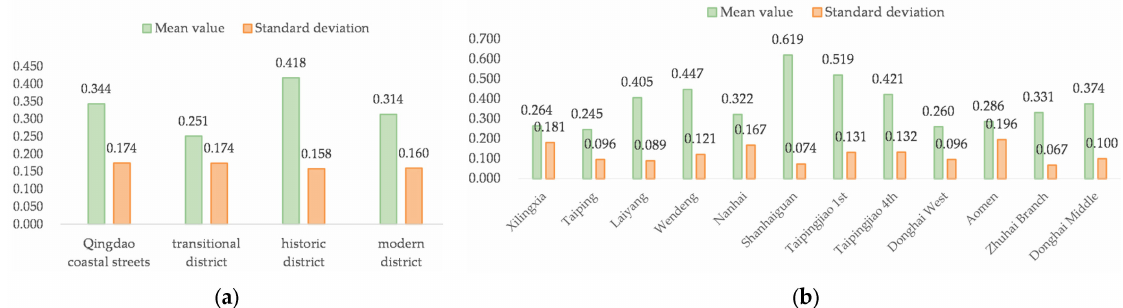
Figure 6. ( a ) The descriptive analysis of GVI values in the overall Qingdao Coastal Streets and the three types of districts; ( b ) the descriptive analysis of GVI values in the 12 roads. Figure 6b shows that: (1) The GVI of Laiyang Road (0.405), Wendeng Road (0.447), Shanhaiguan Road (0.619), Taipingjiao 1st Road (0.519), Taipingjiao 4th Road (0.421) and Donghai Middle Road (0.374) were higher than overall Qingdao Coastal Streets (0.344), and the green quantity was large; the GVI of Xilingxia Road (0.264), Taiping Road (0.245), Nanhai Road (0.322), Donghai West Road (0.260), Aomen Road (0.286), and Zhuhai Branch Road (0.331) was lower than overall Qingdao Coastal Streets (0.344), and the greening needed to be improved. The standard deviations of Xilingxia Road (0.181), Wendeng Road (0.121), Nanhai Road (0.167), Taipingjiao 1st Road (0.131), Taipingjiao 4th Road (0.132), and Aomen Road (0.196) were higher, which indicated that the distribution of green quantity was different among them. Taiping Road (0.096), Laiyang Road (0.089), Shanhaiguan Road (0.074), Donghai West Road (0.096), Zhuhai Branch Road (0.067), and Donghai Middle Road (0.100) had lower standard deviations, which indicated that the green quantity distribution was relatively balanced. The greening was continuous. Among the 12 roads, Shanhaiguan Road had the highest GVI value (0.619) and lowest standard deviation (0.074), which showed that the greening distribution of this road overall was lush and balanced. It provided a valuable reference for the green design; Taiping Road had the lowest GVI value (0.245) and low standard deviation (0.096), which showed that there were fewer plants in all sample points of Taiping Road. The street greening should be improved.